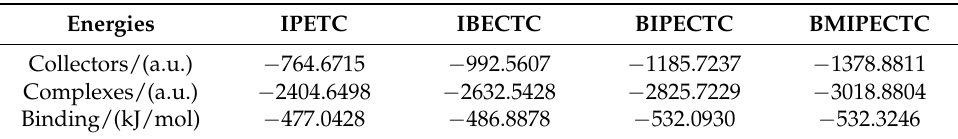
Table 6. Calculated energies in the binding